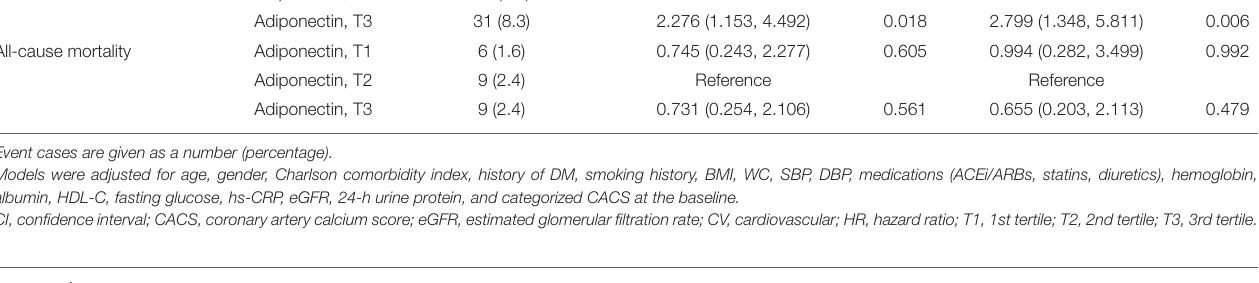
TABLE 3 | Binary logistic regression of serum adiponectin levels for progression of CAC. Number of events (%)